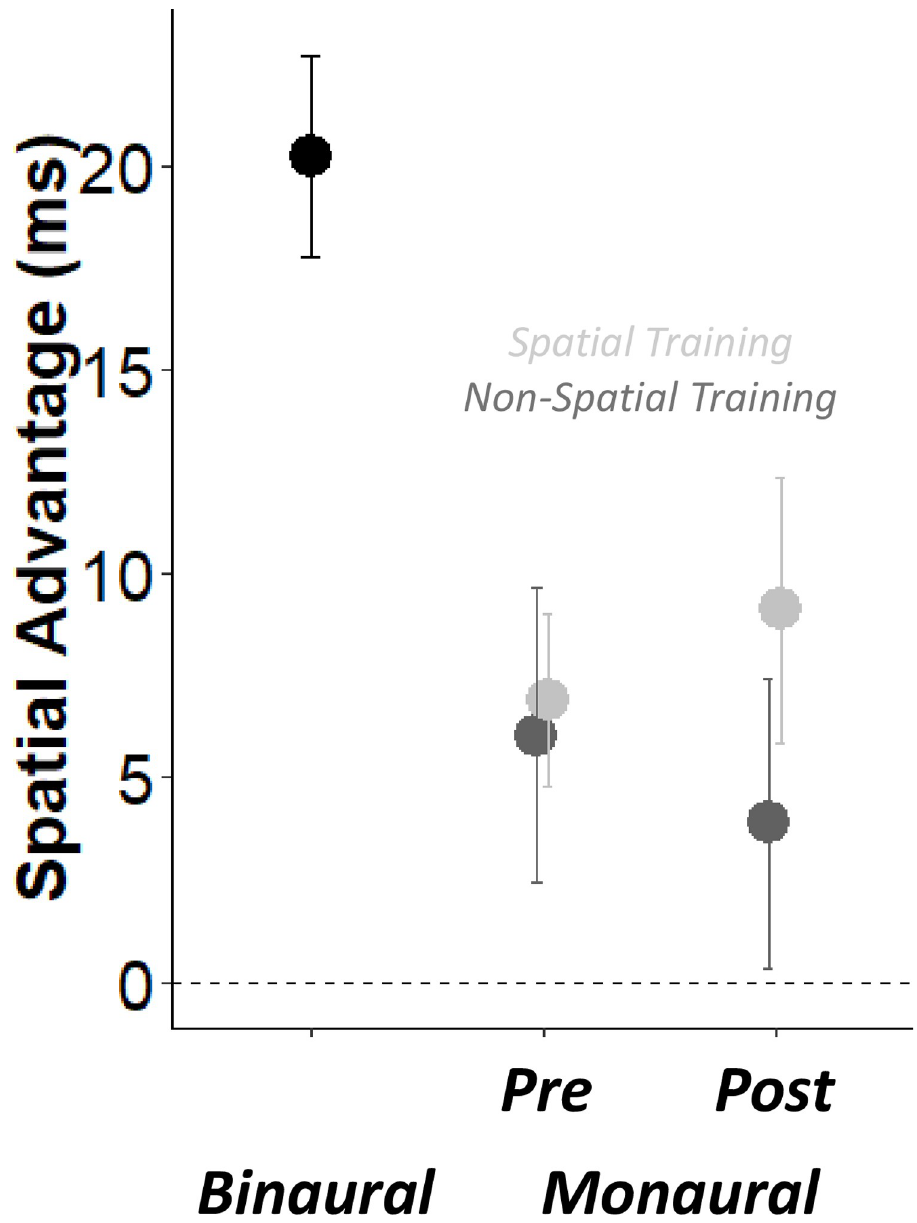
Fig 8. Audio-Visual Cueing task. Audio visual cueing (ms) as a function of PHASE and TRAINING (Spatial in light grey and Non-Spatial in dark grey). (i.e., generalize) to other untrained sound localization tasks. Using a crossover experimental design, we examined the effects of a Spatial training (indicate sound position through reach- ing) on two tasks performed before and after the training session: a head-pointing to sound task and an audio-visual attention cueing task. As a control, we used a Non-Spatial training (indicate sound type through reaching). Three main findings emerged. First, we confirmed that listeners using an ear plug can rapidly improve sound localization while performing a Spa- tial training based on reaching to sounds [25]. Second, we found that the improvements